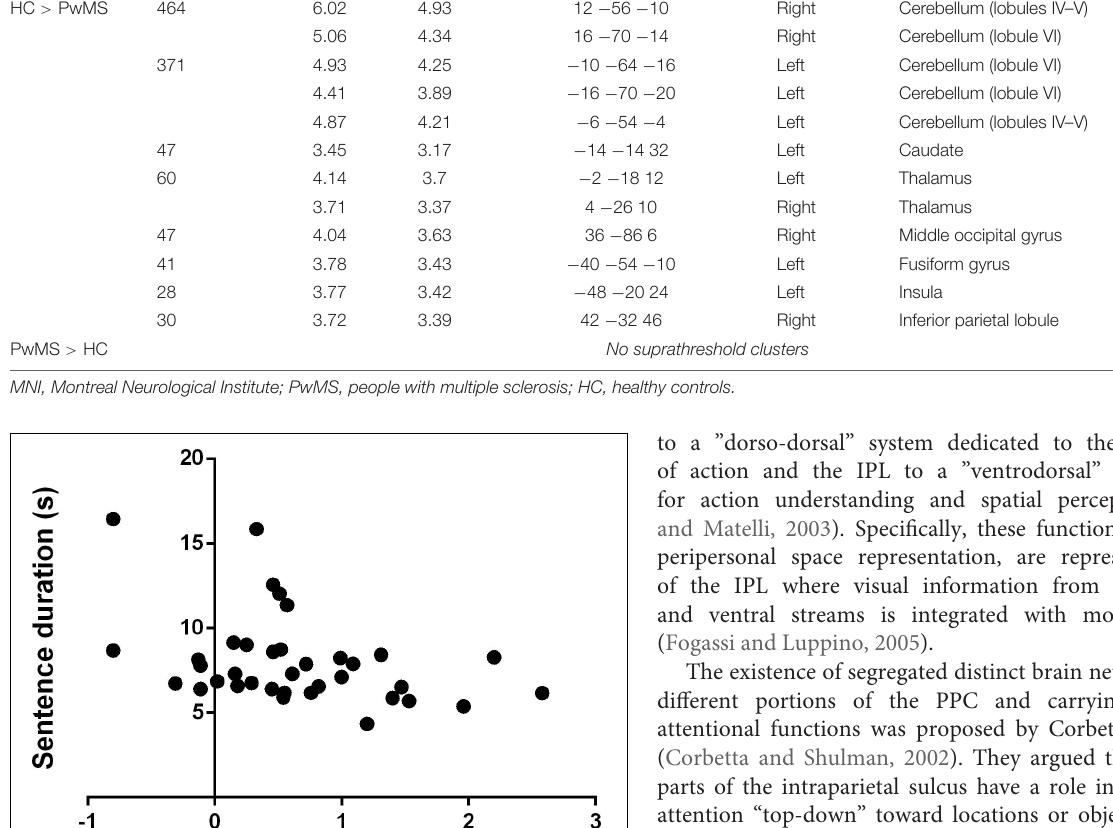
TABLE 2 | Brain regions resulting from the statistical contrasts between the brain activation patterns of the two groups during the handwriting motor task ( p < 0.001, minimum cluster size k = 20 voxels). Comparison Cluster size Voxel T